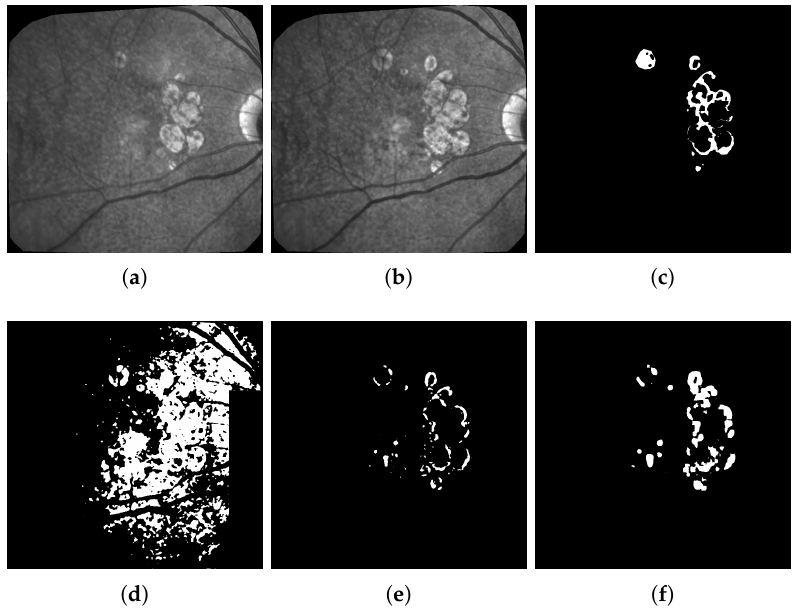
Figure 10. Comparison example of the three methods on patient 001. ( a ) Corrected Image from April 2017; ( b ) Corrected Image from October 2017; ( c ) Proposed ground truth; ( d ) Asano Kanezaki’s approach, F1 score = 0.17; ( e ) Turgay Celik’s approach, F1 score = 0.43; ( f ) Our Fully convolutional AE, F1 score =